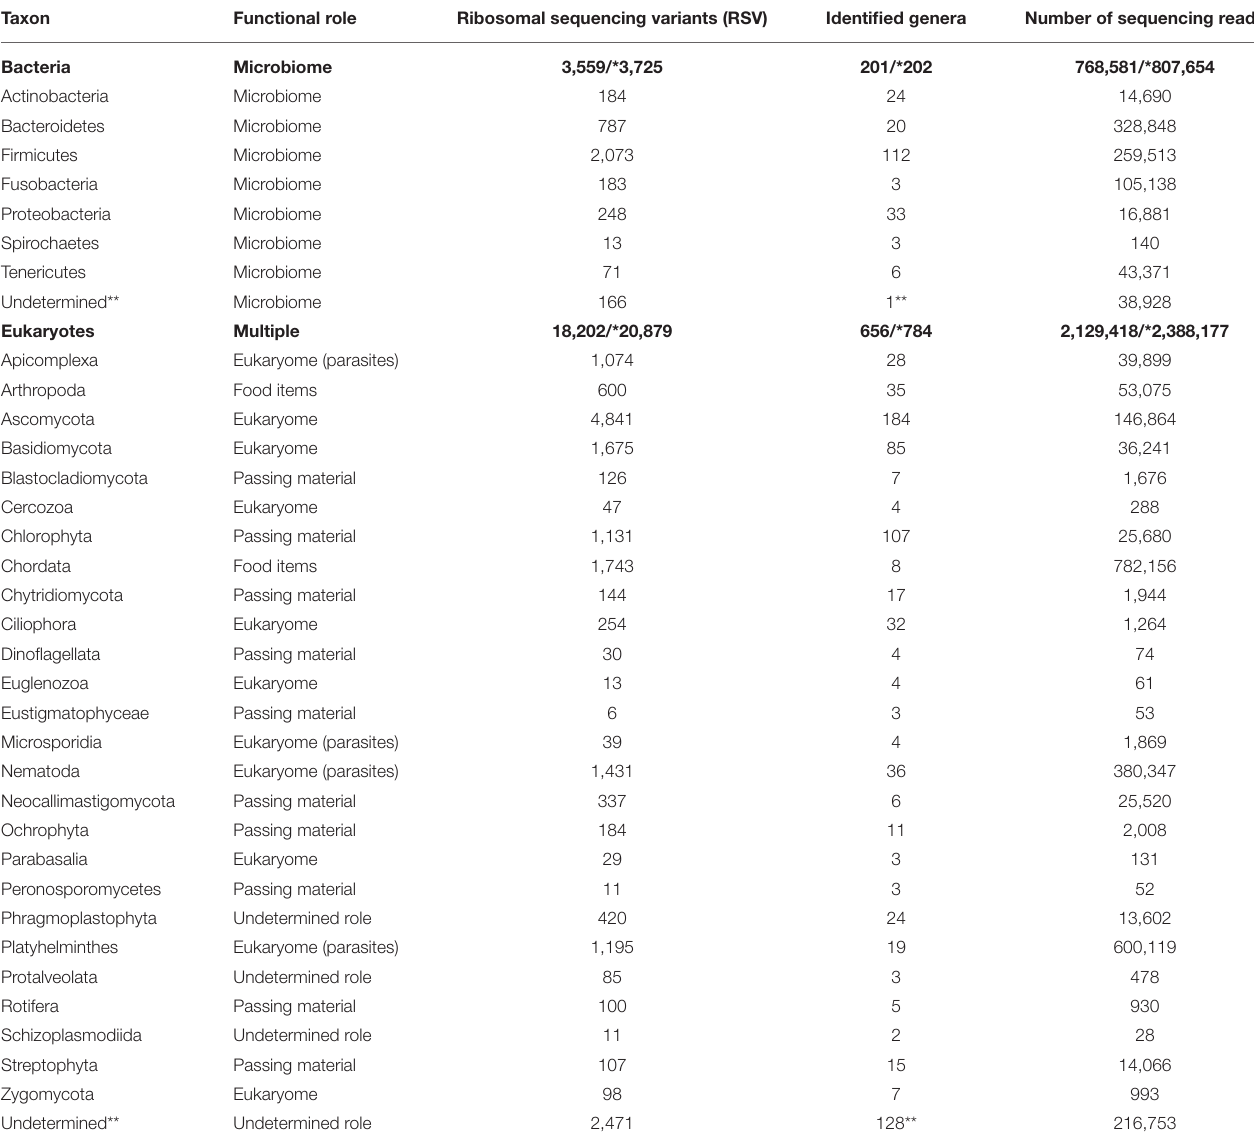
TABLE 1 | The diversity of genera and phyla of bacteria and eukaryotes recorded from the intestinal biome of the spotted hyena as extracted by amplicon sequencing of fecal